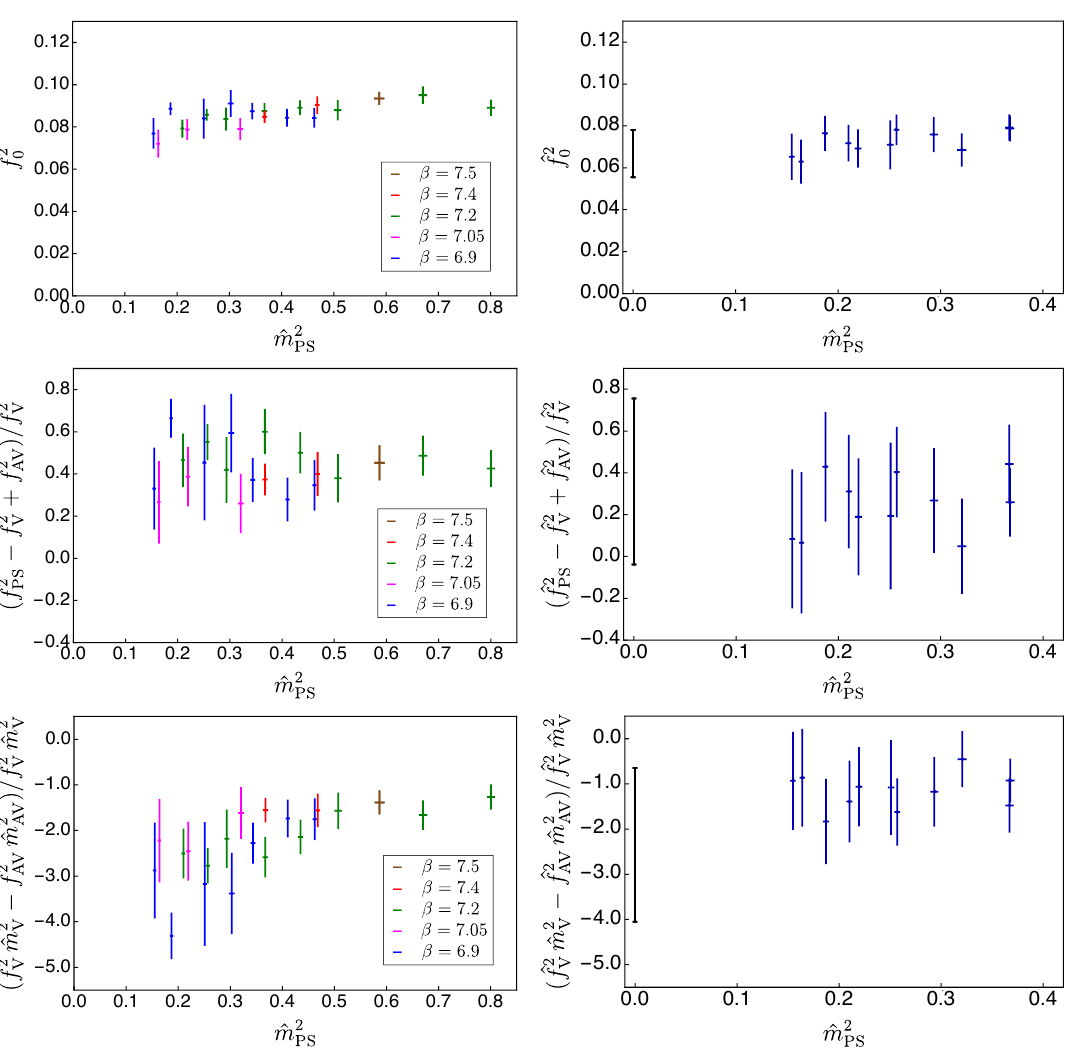
f 2 m 2 , respectively, are shown in the middle and bottom panels of (cid:12)gure 15. As the (cid:12)gures V V show, after continuum extrapolation the results are closer to saturating the Weinberg sum rules. The conservative estimate of the uncertainties includes both statistical and systematic error, and with its current size this comparison is somewhat